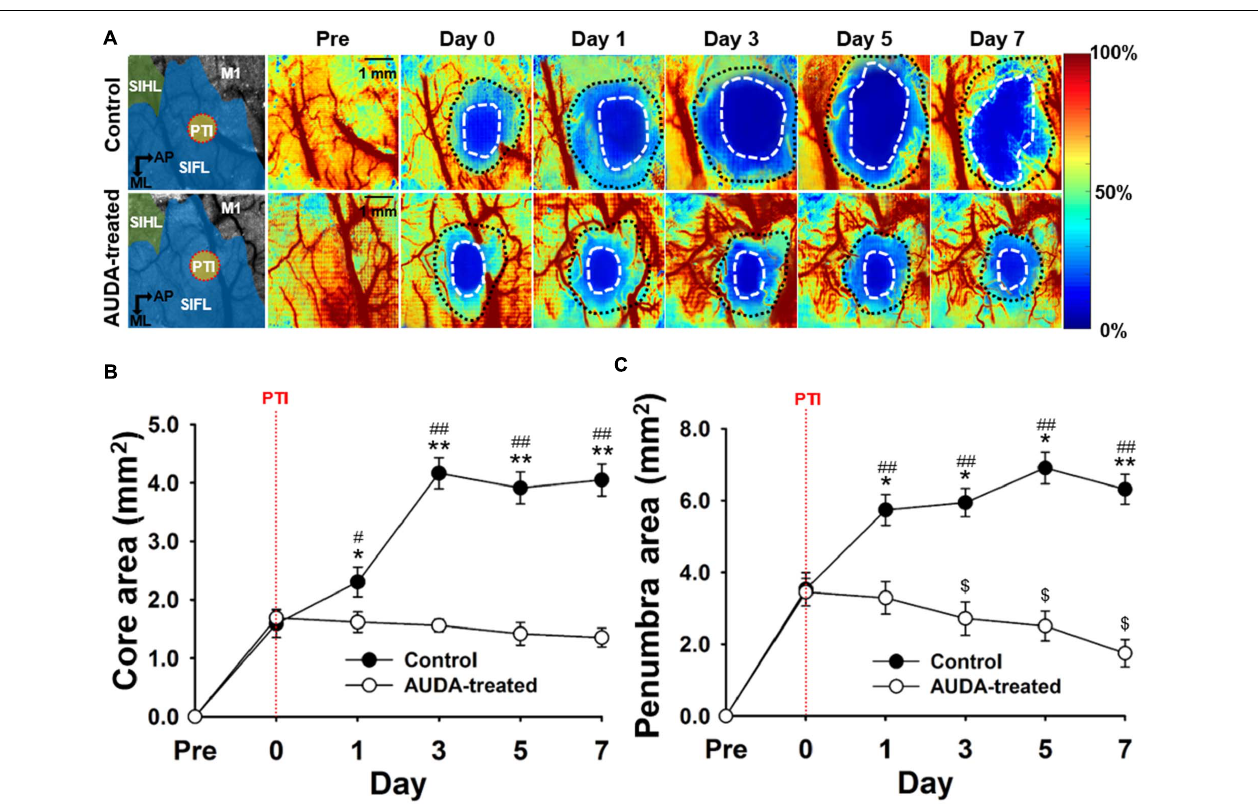
FIGURE 4 | Comparison of ischemic core and penumbra region changes following PTI stroke. (A) Pseudo-color maps of the rCBF percentage change, based on the rCBF value before PTI stroke on day 0. The white dot circled area indicates the ischemic core with a threshold of 20% changes in rCBF. The area between the white dotted circle and black dotted circle contains the ischemic penumbra with a range of 20–50% changes in rCBF. The schematic diagrams of the brain area with S1HL, S1FL, and M1 area as well as the position of PTI induction are shown in the left panel. The scale bar is 1 mm. (B) The core size in the AUDA-treated group was significantly smaller than that of the control group from day 1 to day 7. Compared with the core size on day 0, the core size of the control group significantly increased on post-stroke day 1. The core size in the AUDA-treated group did not show significant changes following PTI stroke. Significant differences between groups are indicated by * p < 0.05 and ** p < 0.01 and indicated by ## p < 0.01 compared with day 0 in both group (two-way ANOVA followed by Bonferroni post-hoc test). (C) The penumbra size in the AUDA-treated group was significantly reduced compared with that in the control group since post-stroke day 1. In addition, compared with day 0, a significant decrease in penumbra size was observed in the AUDA-treated group post-stroke day 3. Conversely, a significant increase in penumbra size was observed since post-PTI stroke day 0. Significant differences between groups are indicated by * p < 0.05 and ** p < 0.01, by # p < 0.05 and ## p < 0.01, and by $ p < 0.05 compared with day 0 in the control group (two-way ANOVA followed by Bonferroni post-hoc test). Data are presented as the mean ± SEM. N = 10 for each group. The red dotted line in both groups indicates the time of PTI stroke